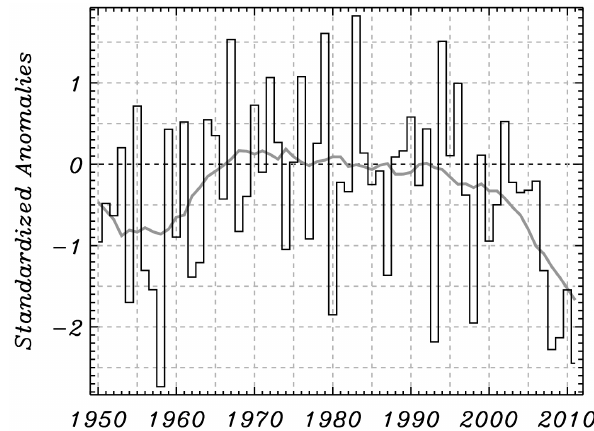
Fig. 8. Summer NAO index anomalies standardized relative to 1970–1999 baseline, indicating an anomalous and persistent nega- tive pattern 2007–2011. The black bars indicate June–August av- erages of monthly anomalies. The grey line represents an 11-yr 4 σ Gaussian running average that becomes increasingly a leading (trailing) average as the beginning (end) point of the time series is reached,